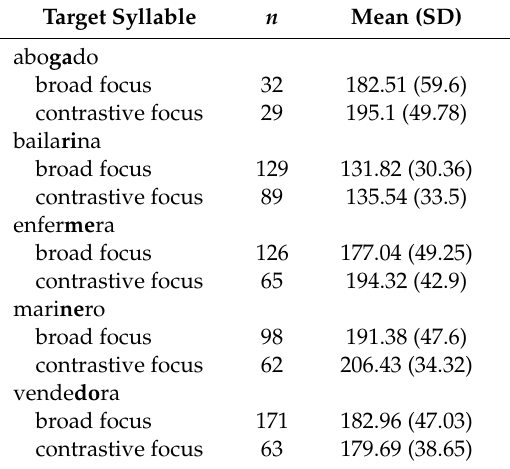
Table 2. Descriptive results for the stressed syllables (in boldface) of the target words in subject position. Mean duration and standard deviations (SD) are indicated in ms.